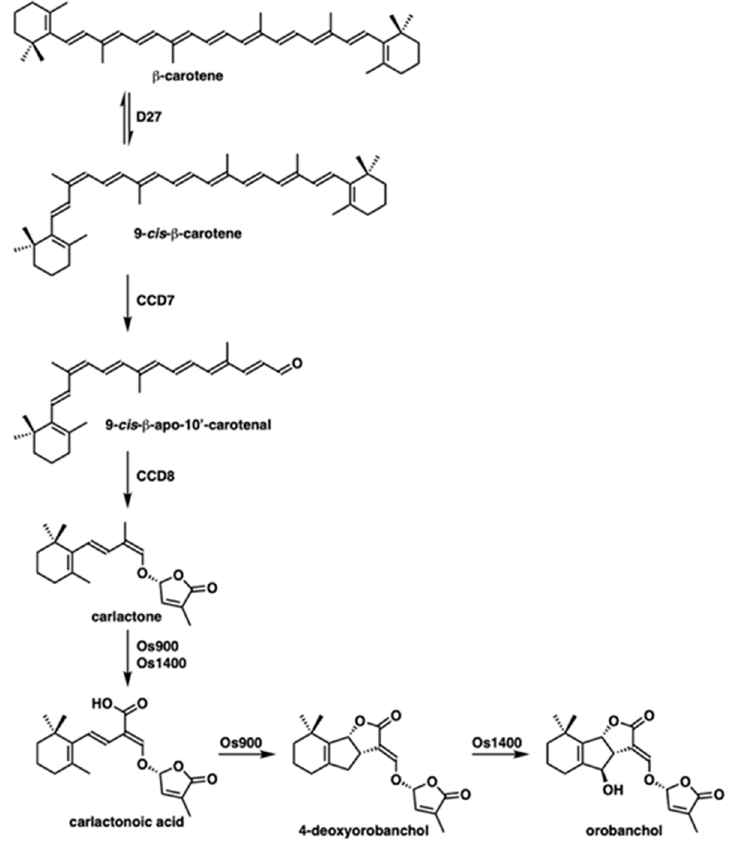
Figure 1. Strigolactone biosynthesis pathway in rice.